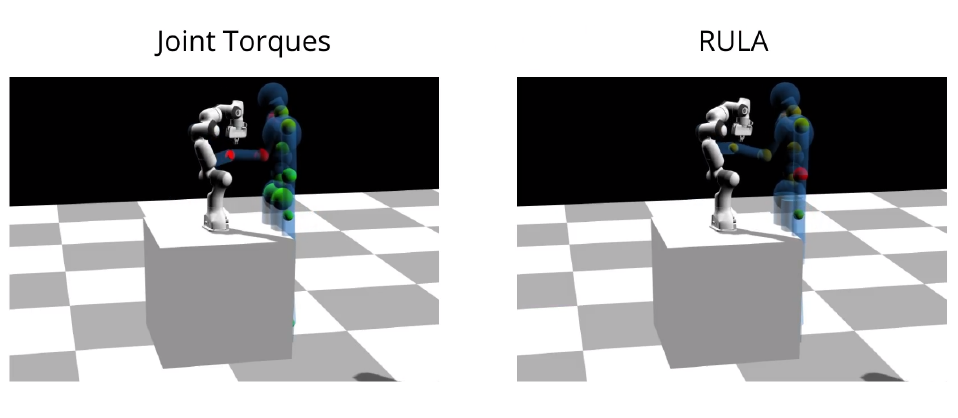
Figure 7. Experiment 2: collaborative object transportation. The DHM with the colored spheres indicating non-ergonomic joint values.